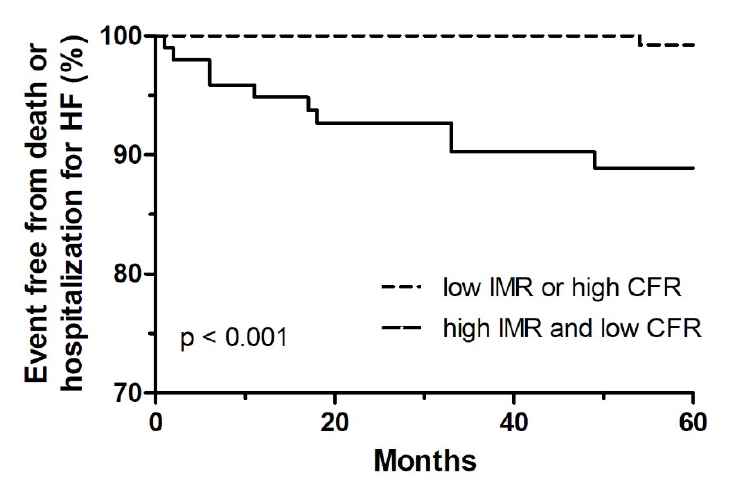
Figure 3. Kaplan-Meier curve of IMR & CFR. CFR: coronary flow reserve; HF: heart failure; IMR: the index of microcirculatory resistance.